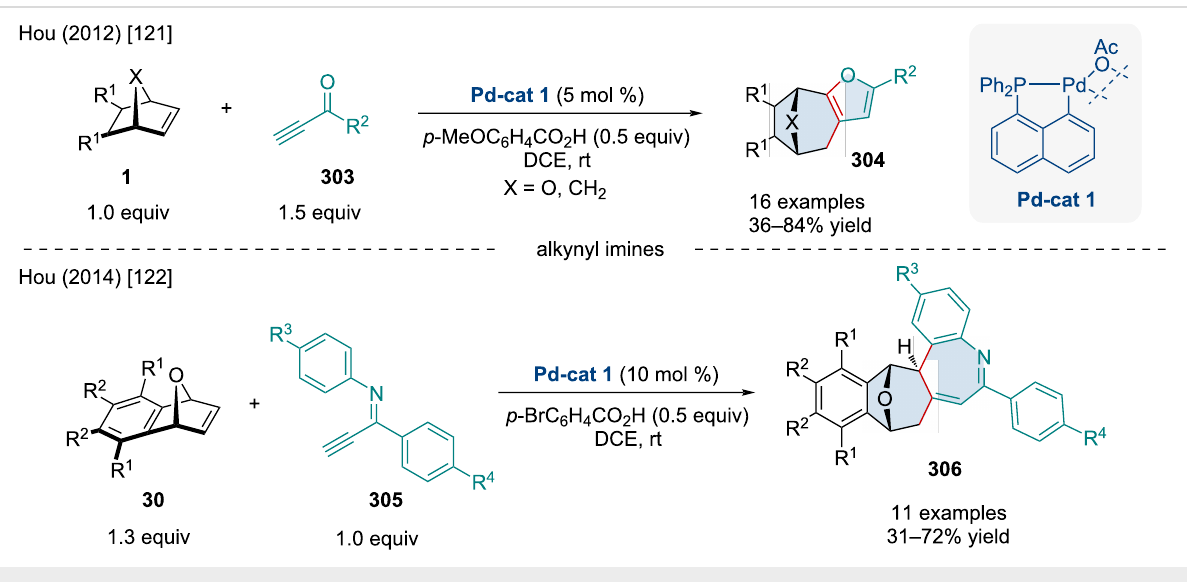
Scheme 64: Palladacycle-catalyzed ring-expansion/cyclization domino reactions of terminal alkynes and bicyclic